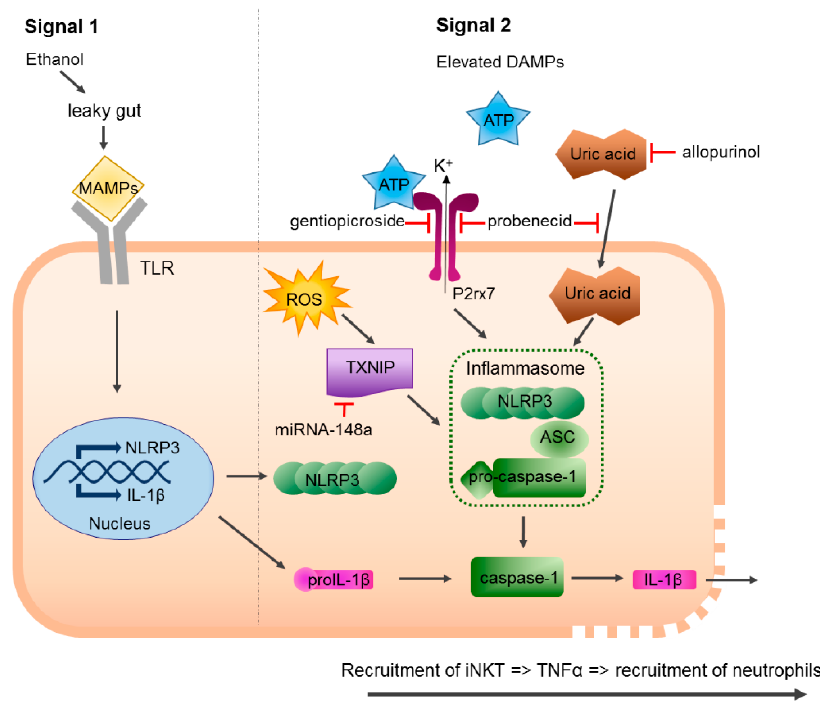
Figure 1. Mechanisms of NLRP3 inflammasome activation and inhibition in alcoholic liver disease (ALD). Constant ethanol exposure results in leakage of bacterial products, termed as microbe-associated molecular pattern, from the gut that trigger TLR-mediated signal 1. Extracellular ATP, uric acid, and ROS are elevated DAMPs in ALD and induce signal 2 leading to NLRP3 inflammasome activation and cleavage of pro-caspase-1 into active caspase-1, which in turn cleaves pro-IL-1 β into mature IL-1 β thereby enabling secretion of this inflammatory cytokine. Released IL-1 β induces activation and recruitment of iNKT cells that produce TNF α and recruit inflammatory neutrophils. NLRP3 inflammasome activation and IL-1 β release can be prevented by substances that inhibit P2rx7-mediated signaling as well as miRNA-148a, which is a suppressor of TXNIP required for inflammasome activation. MAMPs: microbe-associated molecular pattern, DAMPs, danger-associated molecular pattern, TXNIP, thioredoxin-interacting protein, miRNA: micro RNA, ATP: adenosine triphosphate, ROS: reactive oxygen species, P2rx7: purinergic P2X7 receptor, iNKT: invariant natural killer T cell, TNF α : tumor necrosis factor α . The red symbol illustrates inhibition of uric acid by allopurinol. The arrow means that activation of TLR signaling induces expression of NLRP3 and IL-1b mRNA in the nucleus.